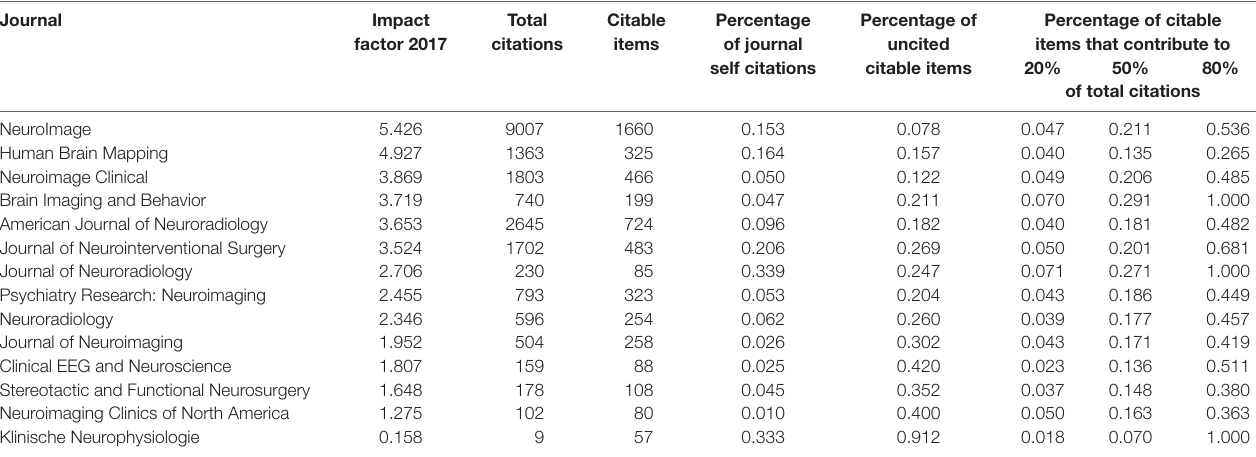
TABLE 1 | Various citation metrics of neuroimaging